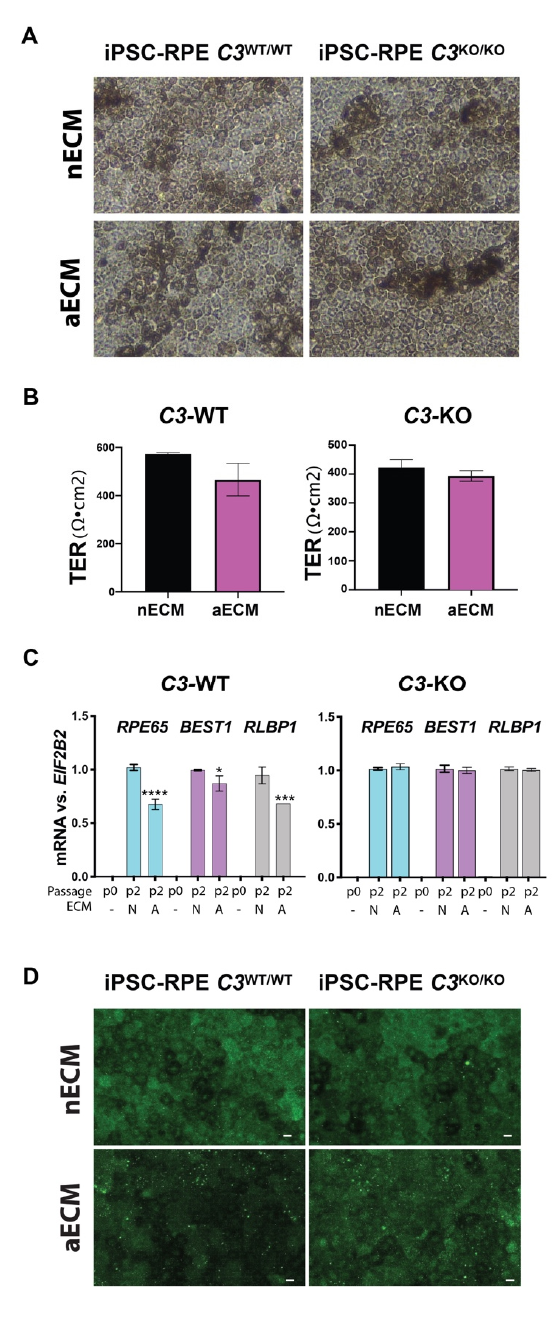
Figure 3. AMD-like substrate causes RPE dedifferentiation. ( A ) Brightfield pictures of mature iPSC- RPE p2 grown for 20 weeks on transwells coated with nECM and aECM. ( B ) TER was measured at 20 weeks in iPSC-RPE C3 WT/WT and C3 KO/KO cultured on transwells coated with nECM and aECM. No significant differences were found; the variability observed among cultures falls within the normal range. n = 2 transwells on nECM and 4 transwells on aECM of each genotype. ( C ) Histograms represent the mRNA levels of RPE65 , BEST1 , and RLBP1 (normalized to EIF2B2 ) expressed by iPSC-RPE C3 WT/WT and C3 KO/KO cells at passage 2 (p2) after 20 weeks in culture. Undifferentiated iPSCs (p0) were used as controls. Data represented as mean ± SD. Two-way ANOVA, **** p < 0.0001, *** p < 0.001, * p < 0.05. n = 4 transwells/type of culture). ( D ) Confocal fluorescent pictures of mature iPSC-RPE p2 grown for 20 weeks on transwells coated with nECM and aECM and immunostained with antibodies anti-RPE65. Scale bars: 10 µ